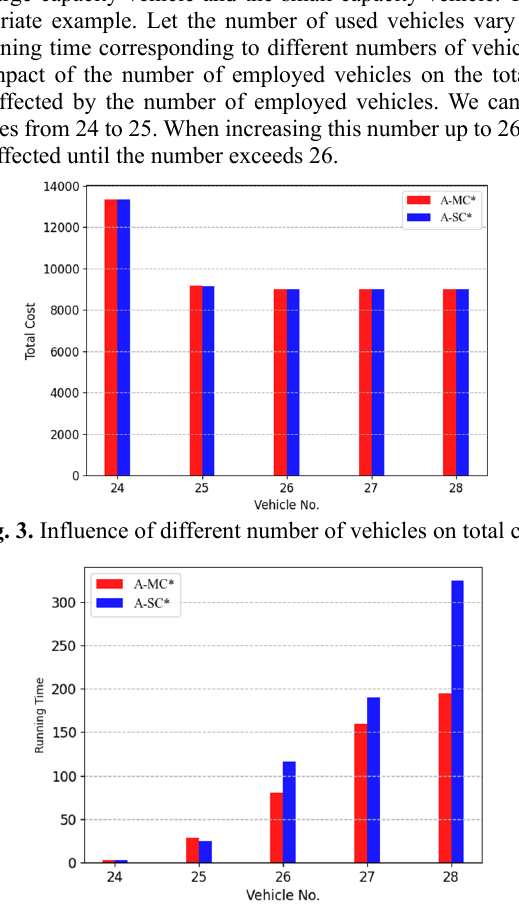
Fig. 4. Influence of different number of vehicles on running